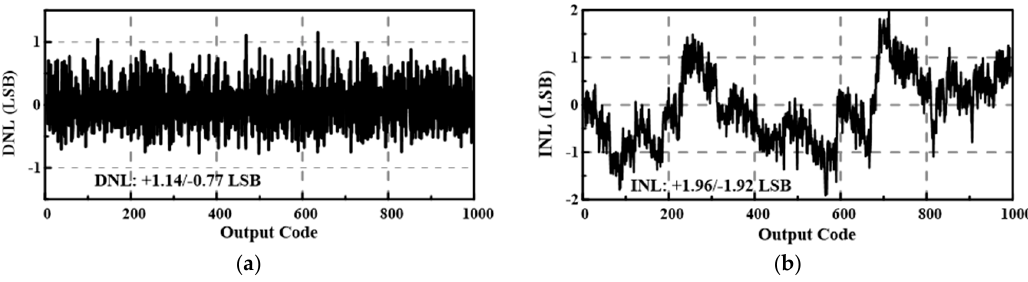
Figure 9. The measured ( a ) DNL and ( b ) INL of the proposed ADC when a sinusoidal fluctuation of 50 mV pp is added to the 0.8 V power supply.